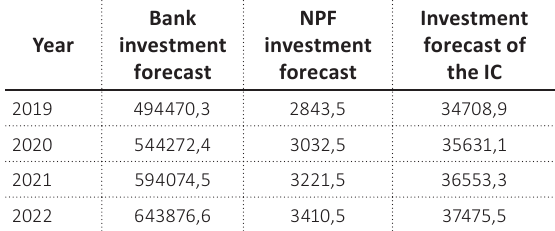
Table 2. Results of basic parameters forecast